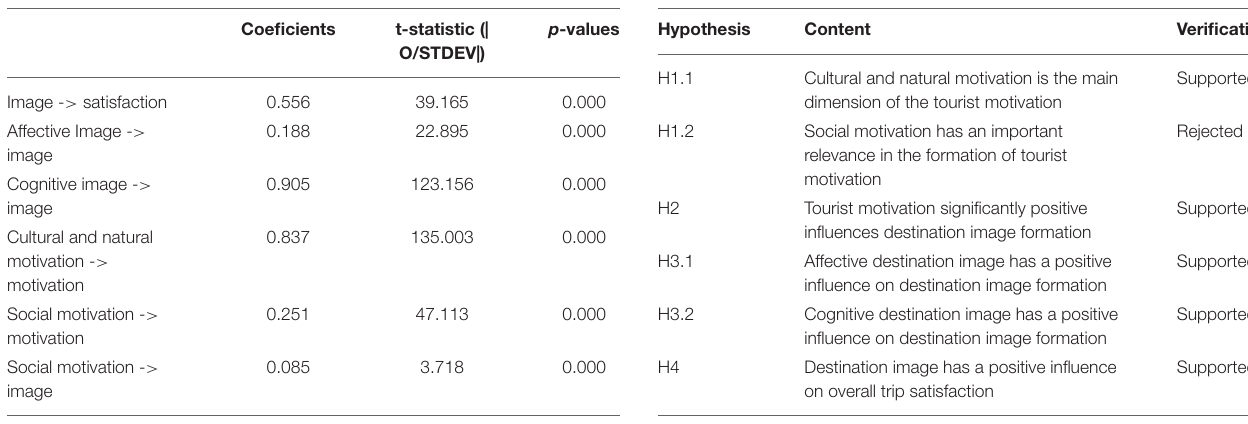
TABLE 11 | Summary of hypothesis